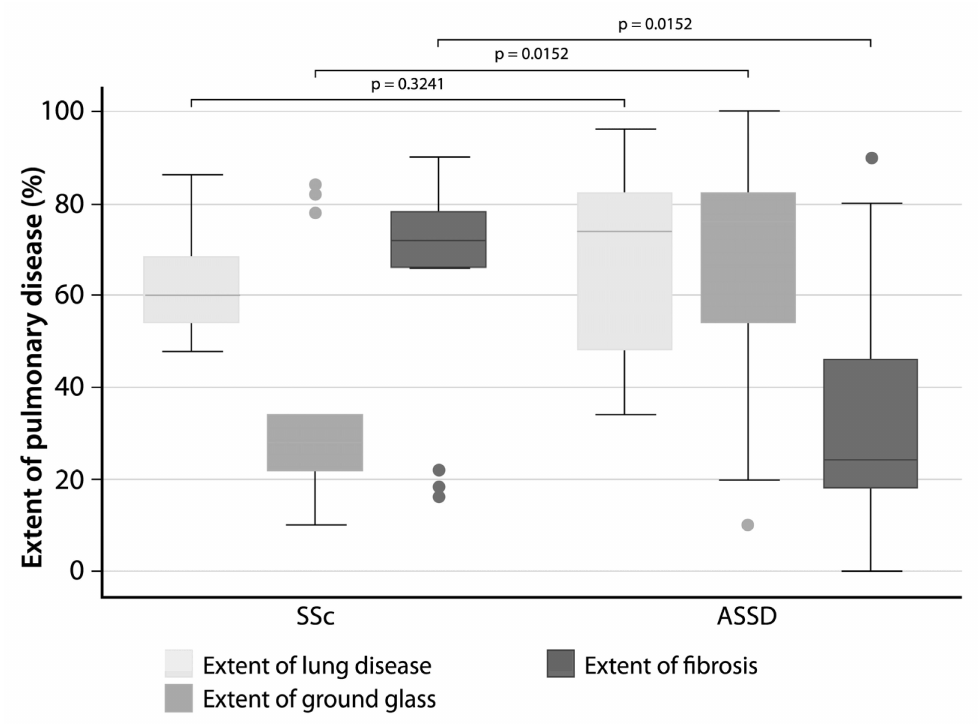
Figure 2. Comparison of tomographic findings between anti-synthetase syndrome (ASSD) patients and systemic sclerosis (SSc). The Goh score in a grayscale shows the total extent of lung disease on HRCT (fibrotic + inflammatory component), the extent of ground glass, and the fibrotic